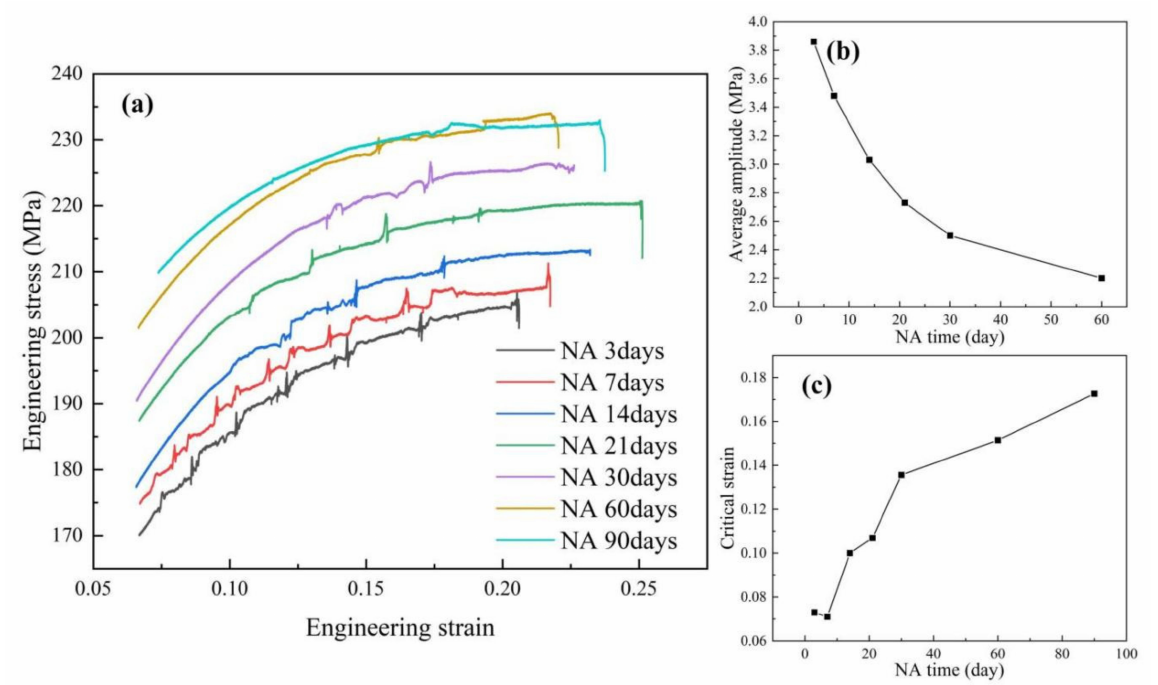
Figure 17. The PLC phenomenon during the NA process ( a ); the changes of average amplitude during the NA process ( b ); and the changes of critical strain during the NA process ( c